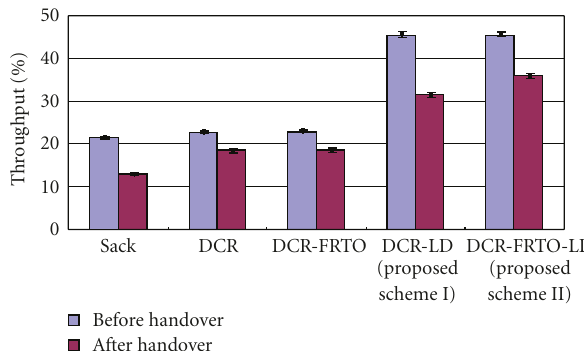
Figure 14: Handover from WLAN to cellular network under